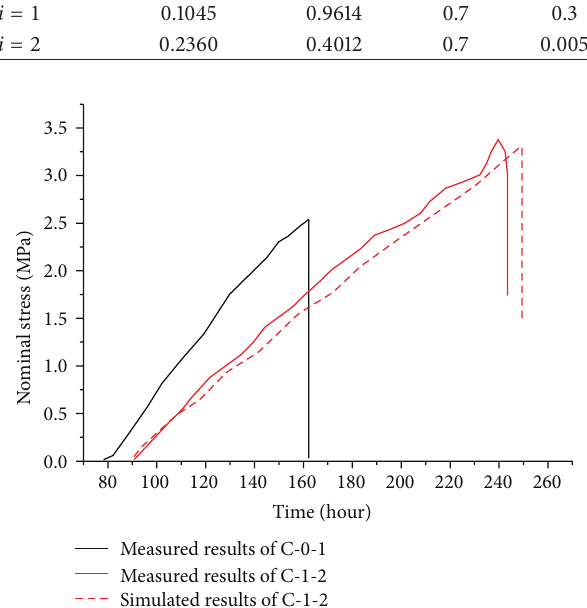
Figure 14: Flow chart of stress calculation.